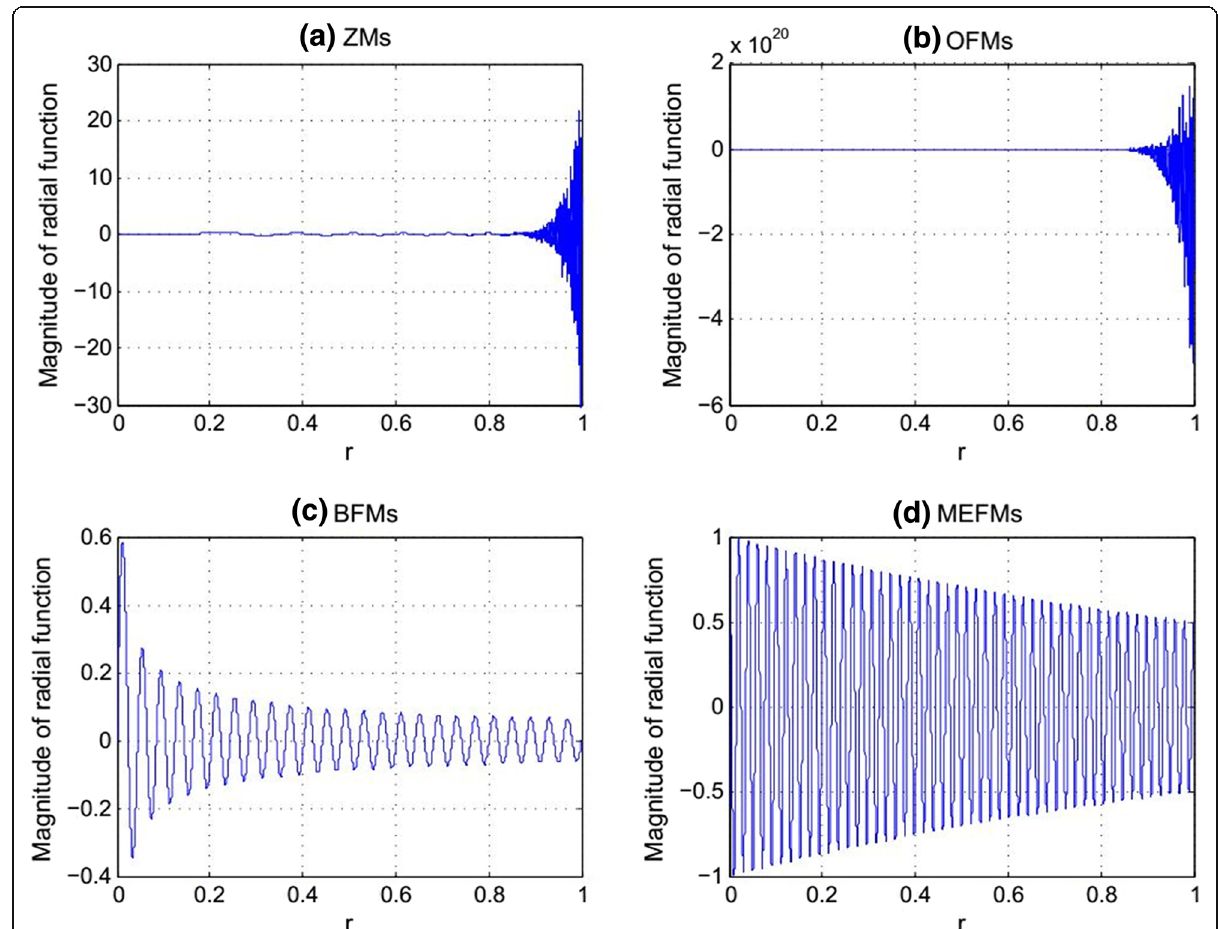
Fig. 3 a – d Radial polynomials of the ZMs, OFMs, BFMs, and MEFMs in higher-order